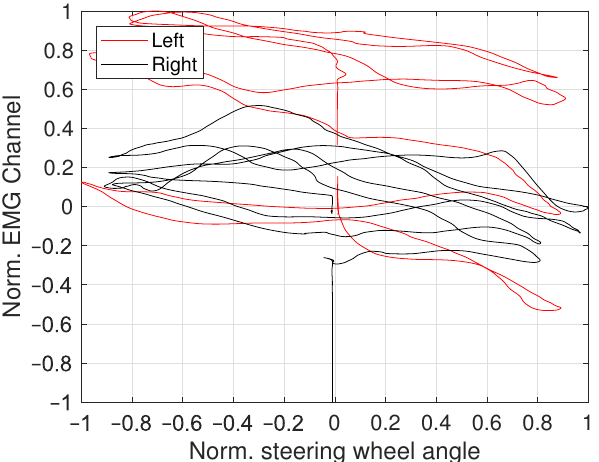
Figure 10. Normalized muscle activity over normalized steering wheel angle (front